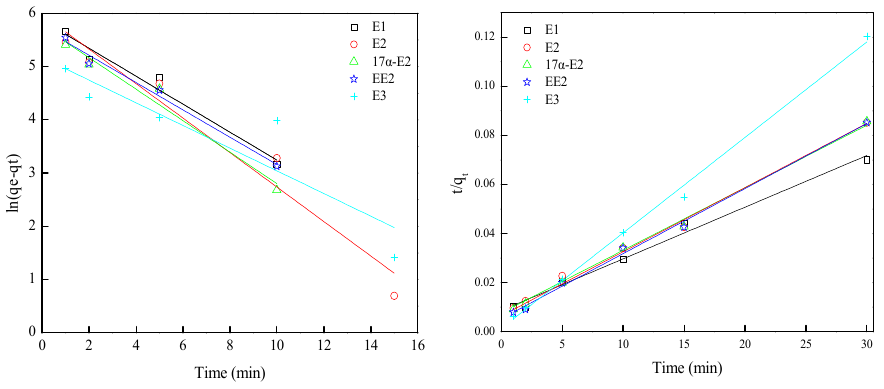
Figure 8. Plots of pseudo-first-order and pseudo-second-order kinetic models. Table 2. Kinetic parameters for pseudo-first-order and pseudo-second-order models.